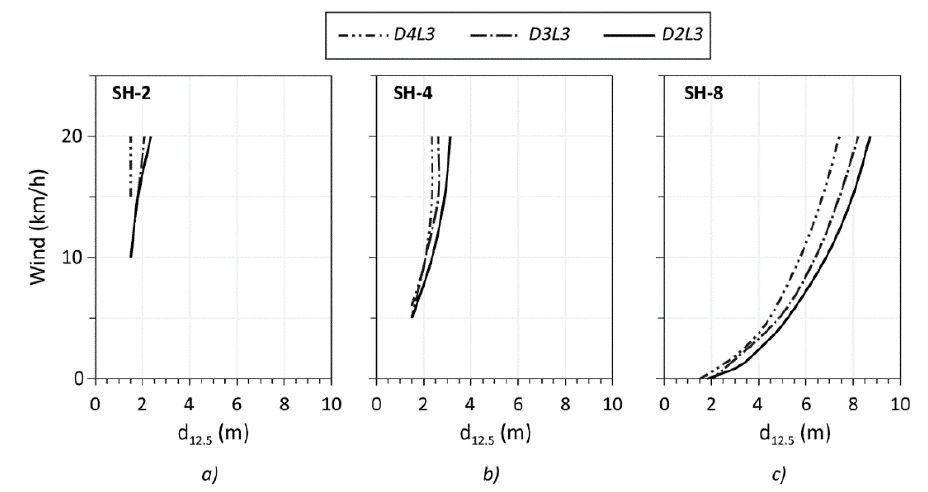
Figure 15. Safe separation distances as a function of wind speed at Moderate MC of live fuel (L3) and variable MC of dead fuel (D2, D3, D4) for each fuel model of SH category: ( a ) SH-2, ( b ) SH-4, ( c ) SH-8.